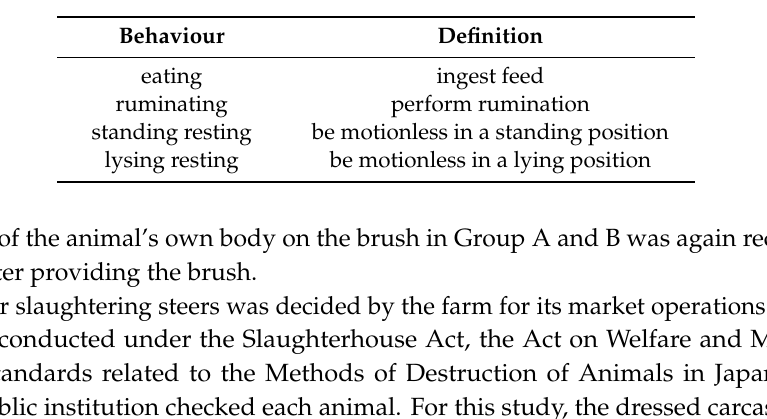
Table 1. Ethogram of the 10 min time sampling in Trial